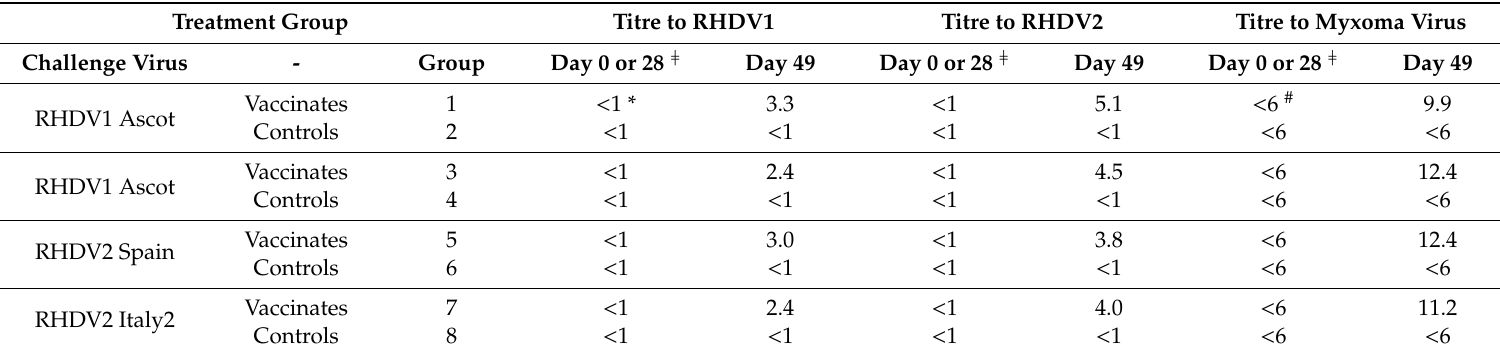
Table 7. Average antibody titre (log 2 ) to classical rabbit haemorrhagic disease virus (RHDV1), the new RHDV genotype (RHDV2) and myxoma virus in DB rabbits. Treatment Group Titre to RHDV1 Titre to RHDV2 Titre to Myxoma Virus Challenge Virus - Group Day 0 or 29 } Vaccinates RHDV1 Ascot Controls < 6 Vaccinates RHDV1 Ascot Controls RHDV2 Italy2